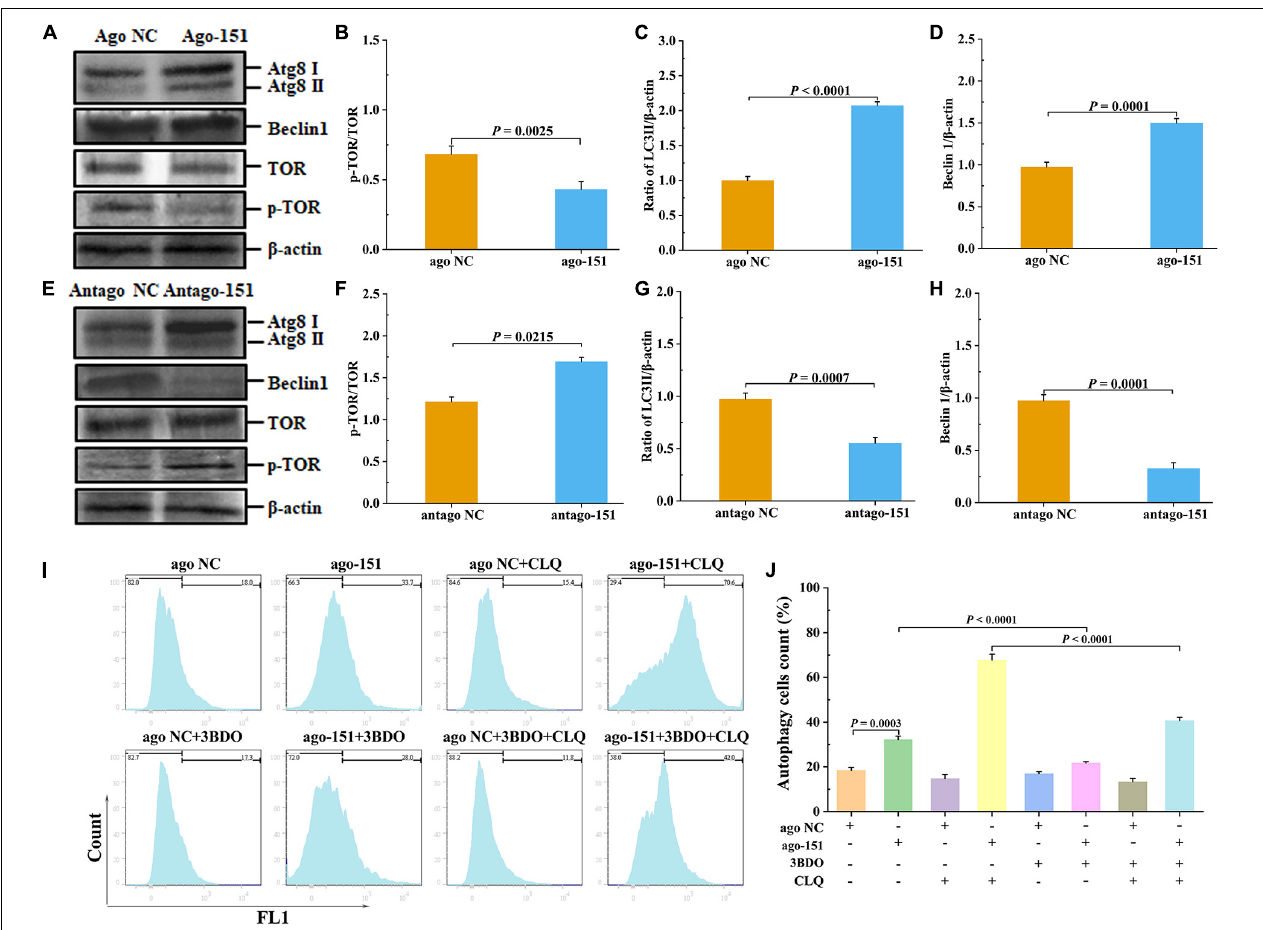
FIGURE 6 | Pva-miR-151 affects low-temperature tolerance of shrimp by inducing the occurrence of autophagy. Shrimp were injected with 2 nM/g ago-151 or antago-151. After 24 h, the shrimp hepatopancreas was collected for Western blot. The Western blot evaluation of shrimp autophagy after ago-151 treatment (A) , p-TOR (B) , LC3 (C) , and beclin1 (D) statistical analysis. The evaluation Western blot of shrimp autophagy after antago-151 treatment (E) , p-TOR (F) , LC3 (G) , and beclin1 (H) statistical analysis. β -Actin was used as the control. The ratios of pTOR/TOR, LC3II/ β -actin, and beclin1/ β -actin gray-scale value were calculated with three independent experiments. Shrimp primary hemolymph cells were treatments with DMSO, 20 pmol NC or miR-151, 8 µ M chloroquine (CLQ), and 50 µ M 3BDO for 24 h to induce autophagy and then used CYTO-ID R (cid:13) Green Detection Reagent 2 stain for 30 min and analyzed by flow cytometry (I) and statistical analysis (J) . Data were shown as fold changes and mean ±